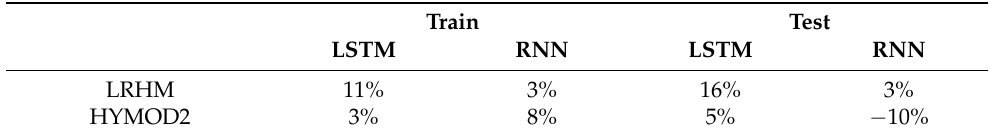
Table 7. Percentage improvement of the performance of the ML approximators over the LRHM and HYMOD2 hydrological models in the Nyangores River case study (sequential